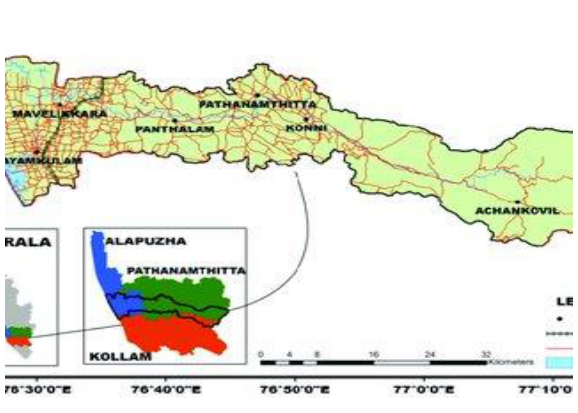
Figure 1. Sampling